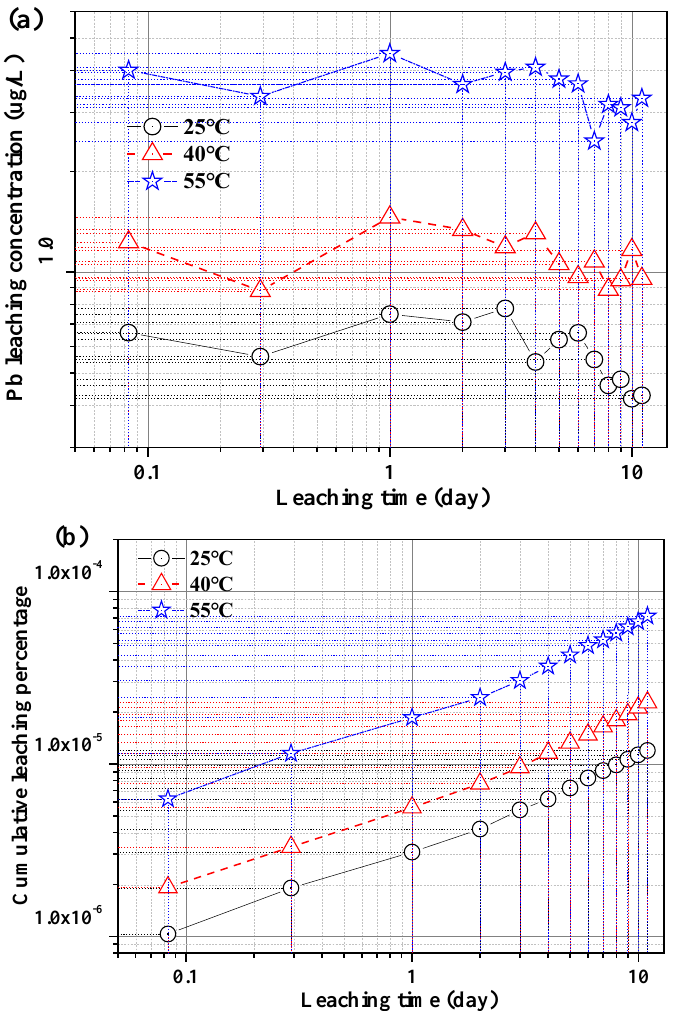
Figure 1. Results for leaching of Pb from S/S monolith at different temperatures: ( a ) Pb concentration in the leachate; ( b ) cumulative leaching amount of Pb.